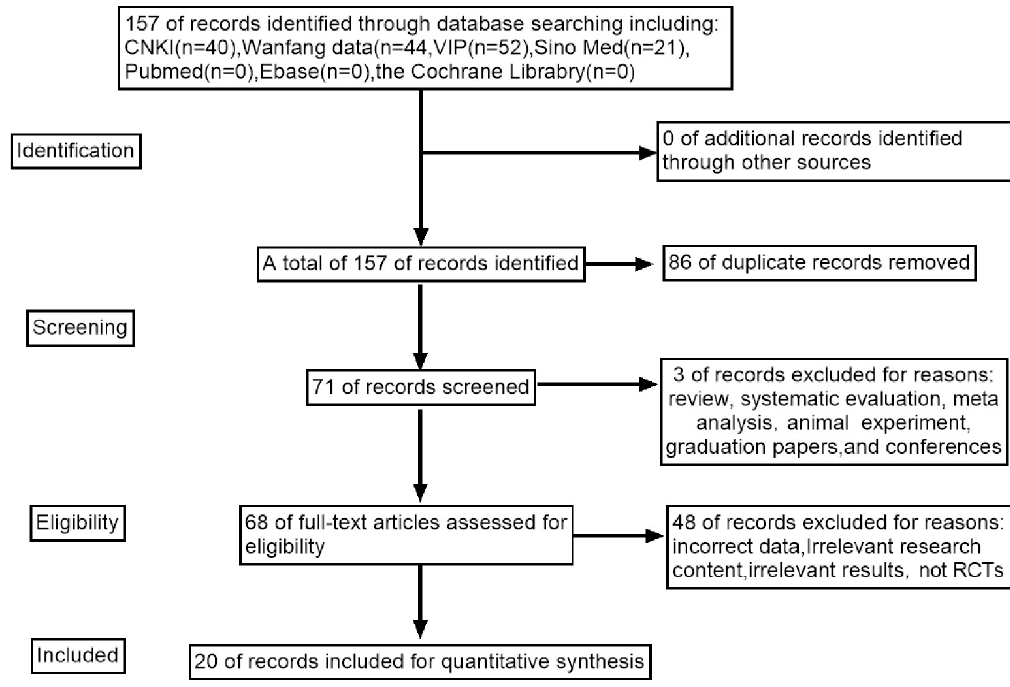
Fig 1. Flow diagram of the search and selection